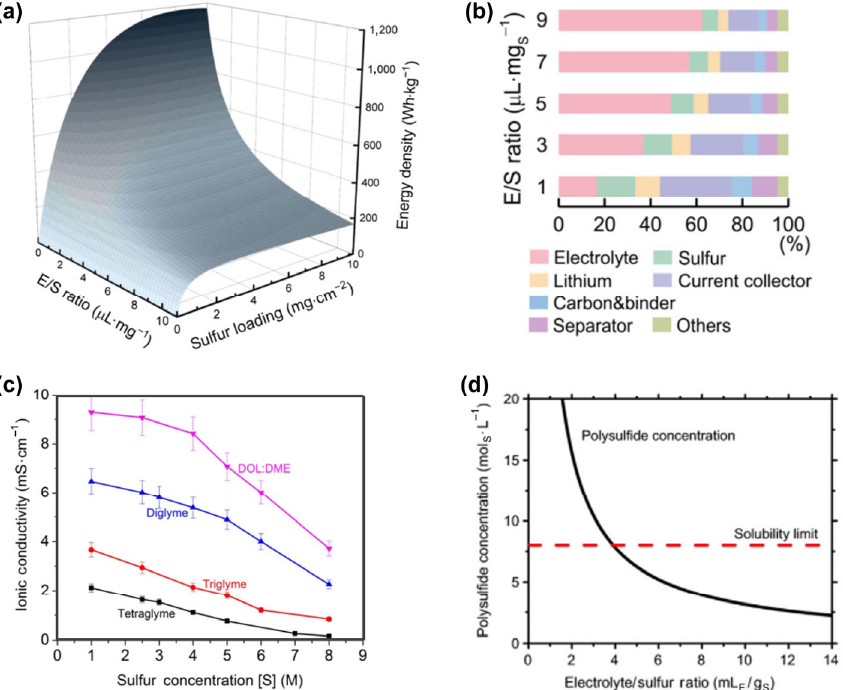
Figure 1 (a) Calculated energy densities, (b) mass ratios of different components, (c) ionic conductivity, and (d) polysulfide concentration of Li–S batteries at different areal sulfur loadings and E/S ratios. Reproduced with permission from Ref. [3], © American Chemical Society 2020; Ref.